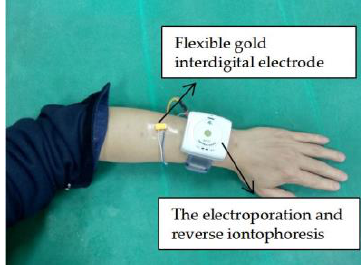
Figure 4. Pictures of skin penetration promotion test with the device of electroporation and reverse iontophoresis.